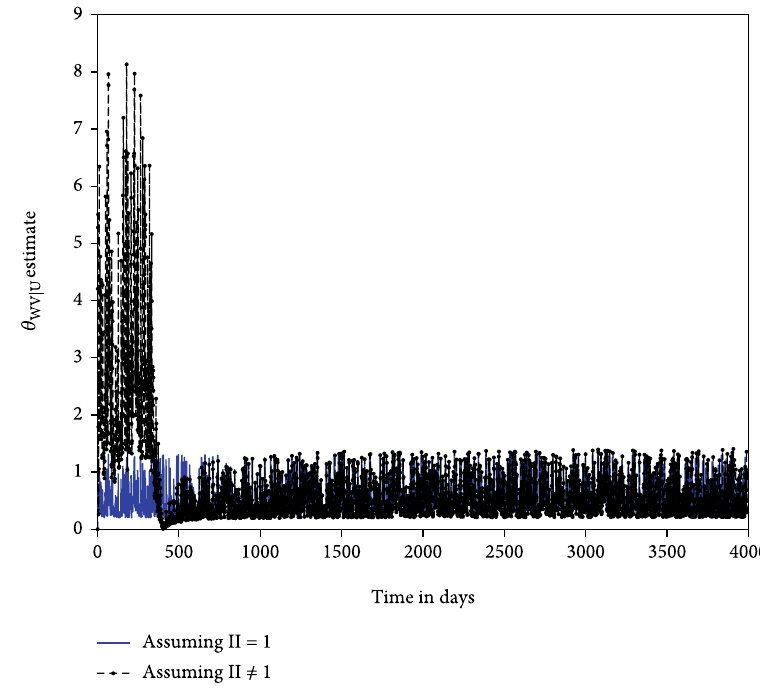
Figure 10: Maximum likelihood estimation of θ